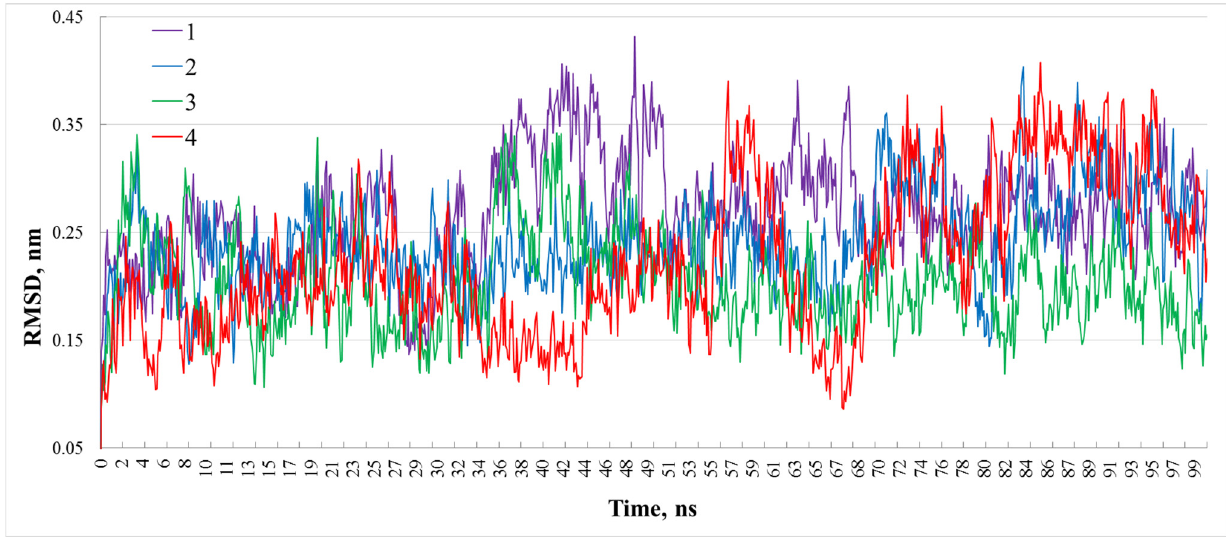
Figure 2. RMSD graphs of C α atoms of different models of dimers simulated in a solution with a precipitant: with Na and Cl ions, bound to the protein (1), only with Na ions in the dimer structure (2), and without precipitant ions embedded in the lysozyme molecule (3), as well as without Na and Cl ions both in solution and in the protein structure (4).